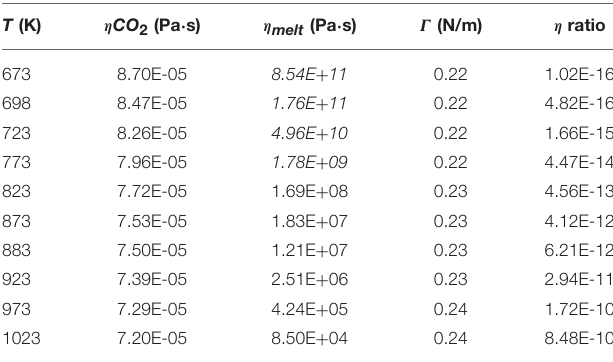
TABLE 1 | Viscosities of CO 2 gas-rich bubbles and haplogranitic melt and their viscosity contrast at different temperatures at 200MPa. T